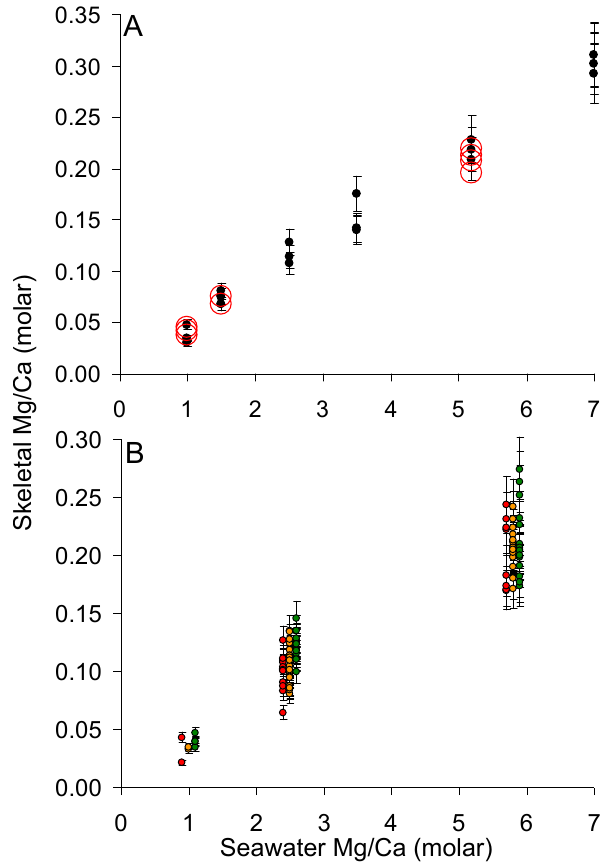
Fig. 20. Mg fractionation data for (A) the encrusting coralline alga Neogoniolithon sp. and for (B) the three species of branch- ing coralline algae Amphiroa A (closed red circles), Amphiroa B (closed orange circles), and Amphiroa rigida (closed green circles) reared in experimental seawater treatments formulated at Mg/Ca ra- tios ranging from 1.0 to 7.0 (from Ries, 2006b; Stanley et al., 2002). Skeletal Mg/Ca ratios increase in lock-step with seawater Mg/Ca ratios. Large open red circles in (A) correspond to skeletal Mg/Ca ratios for specimens of Neogoniolithon sp. reared in a second set of experimental seawaters with Mg/Ca ratios of 1.0, 1.5, and 5.2, that have reduced (1.0, 1.5) and elevated (5.2) absolute concentrations of Mg 2 + and Ca 2 + . Changes in the absolute Mg 2 + concentration of seawater had no significant ( p < 0 . 05) effect on algal skeletal Mg fractionation at fixed ambient Mg/Ca